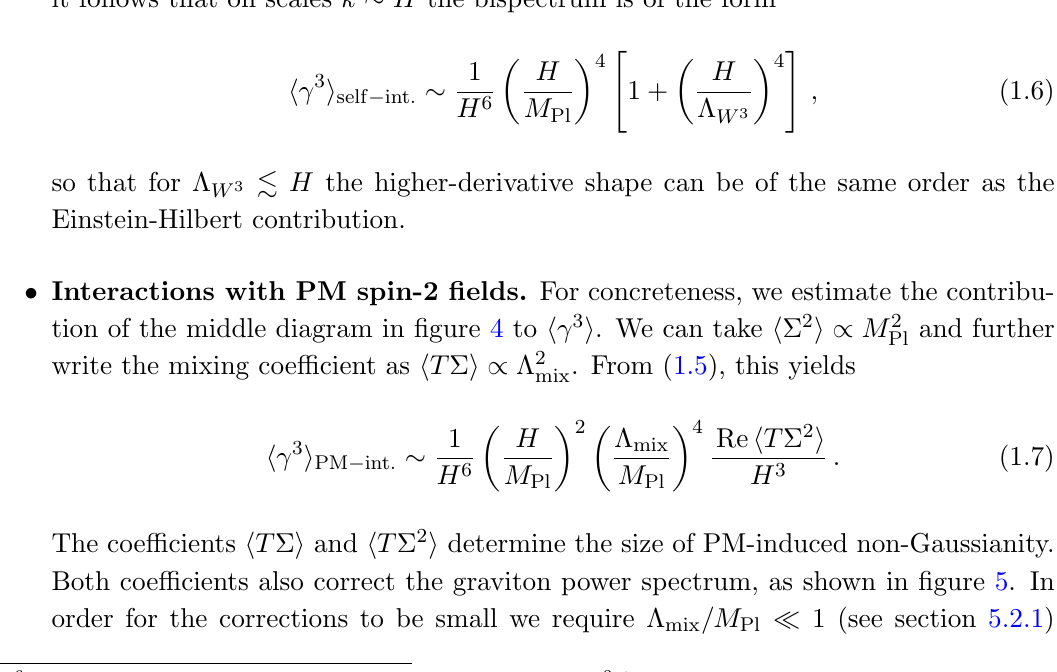
γ 3 . Here, a mixing vertex corresponds to h i − 1 Σ 2 h i